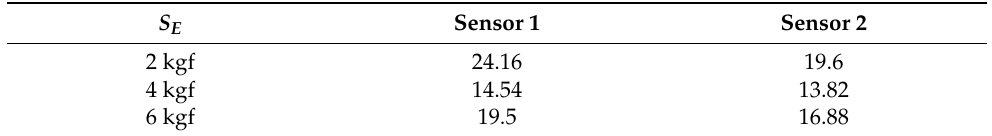
Table 13. Result of sensor data efficiency evaluation for optimal sensor selection of nip roll eccentricity fault.